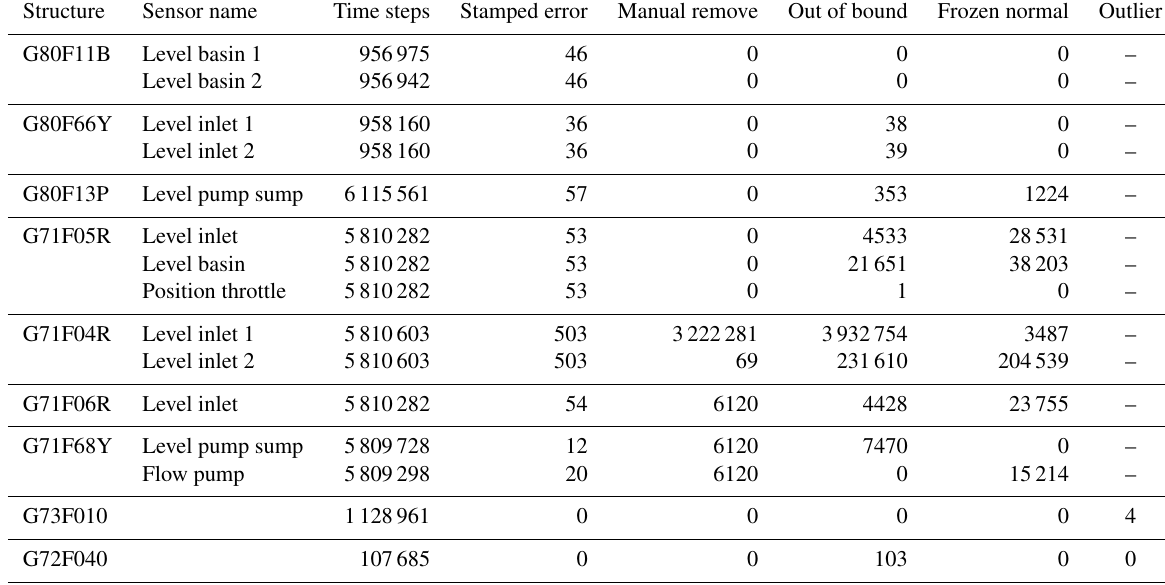
Table 2. Overview of the five error types in data from the different sensors. Values are 1min values. Structure